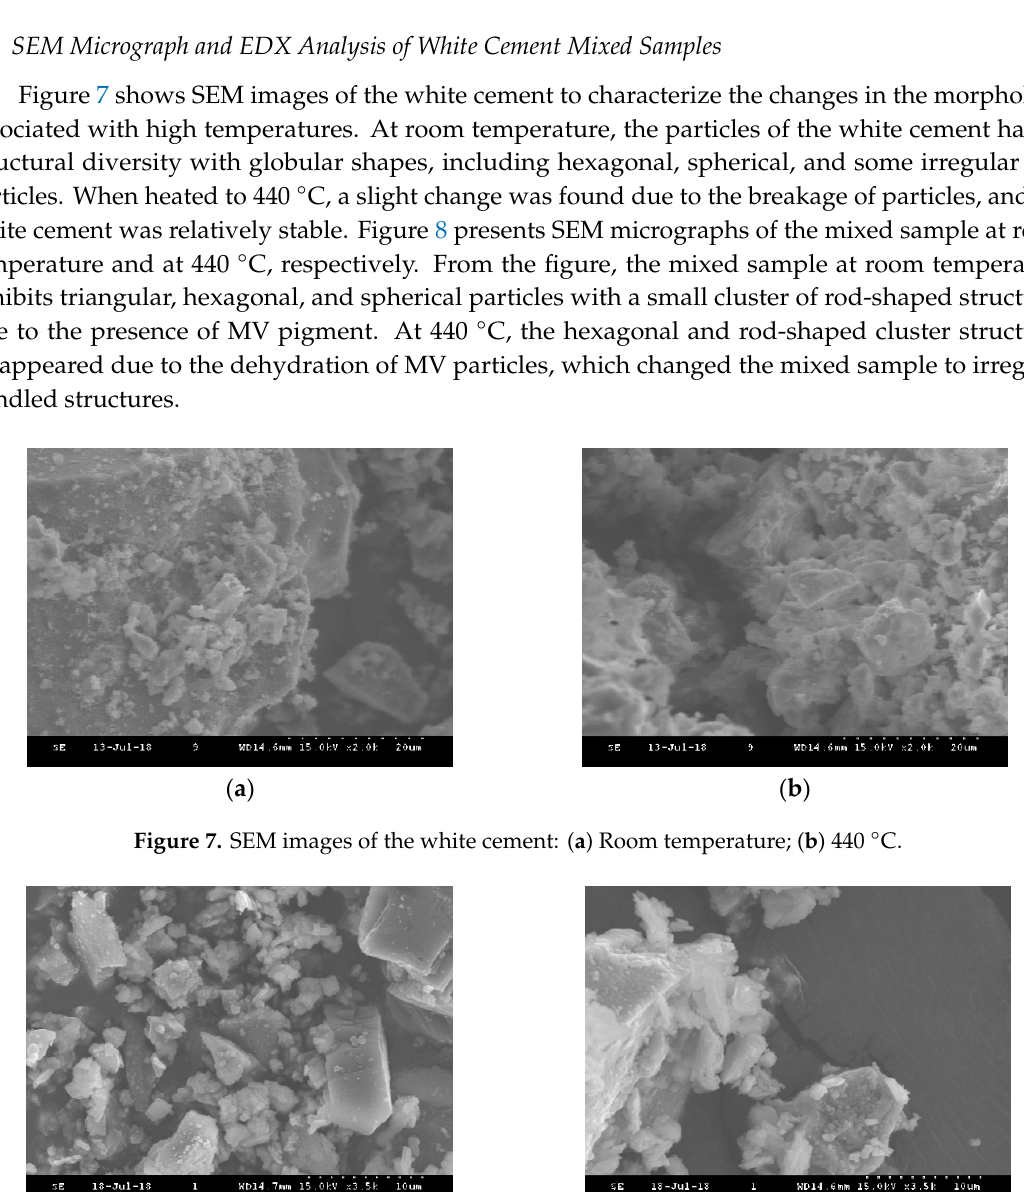
Figure 6. Color changes in the white cement and MV mixed samples exposed to different temperatures (Scale: 1000 × 1000 pixels).